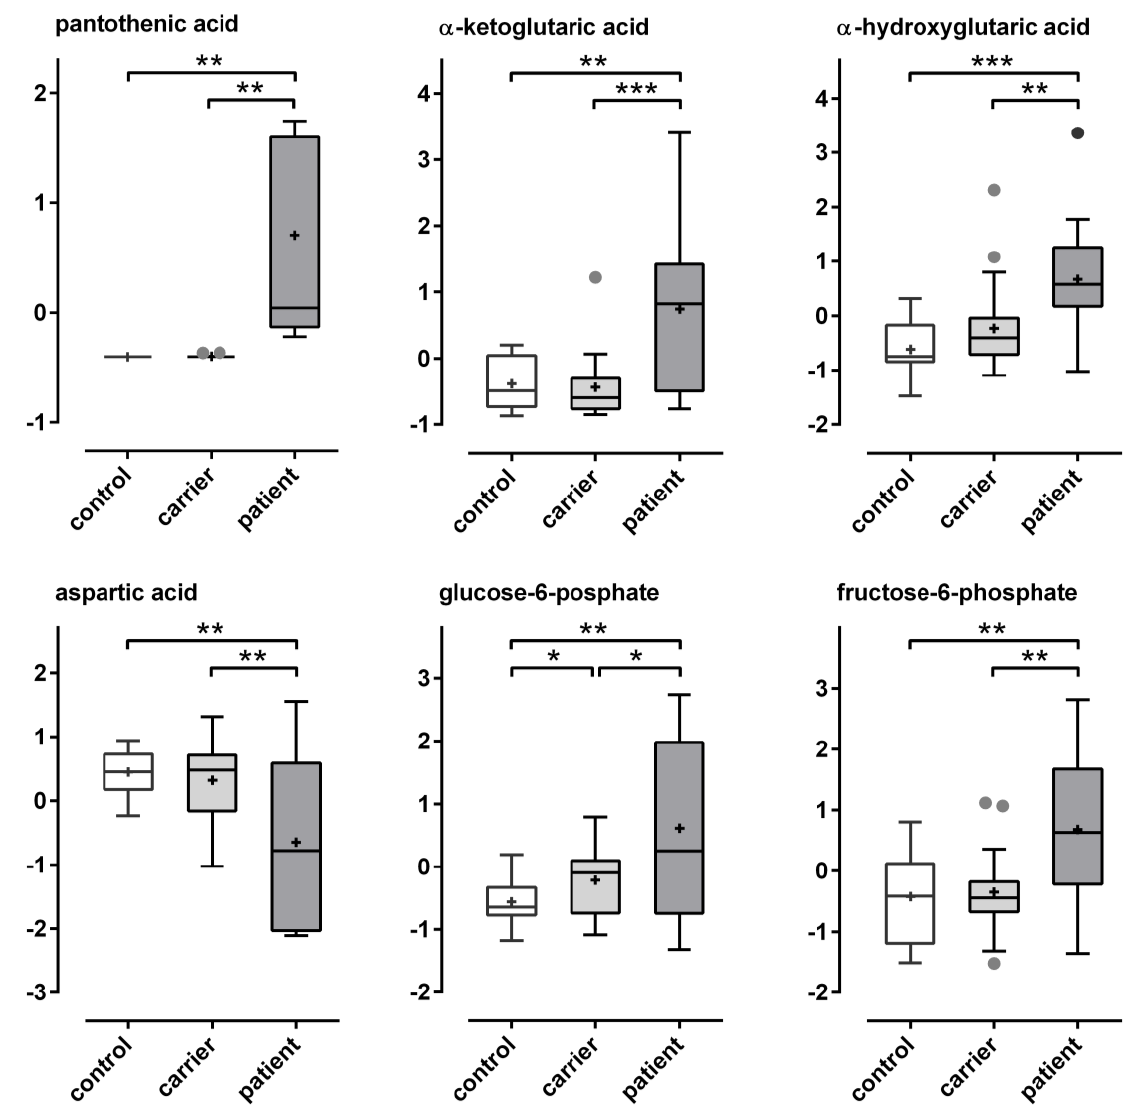
Figure 5. Boxplots of selected metabolites reveal significant alterations in PKAN erythrocytes. The z-normalized data of selected metabolites grouped in patient, carrier, and control samples are given in box-and-whisker plots (GraphPad Prism). Grey points indicate outliers and black crosses mean values. Differences between the groups were analyzed by Student’s t -tests and significant results are indicated by asterisks (* = p ≤ 0.05, ** = p ≤ 0.01, *** = p ≤ 0.001). Boxplots of the other metabolites from Table 3 are given in Figure S1.